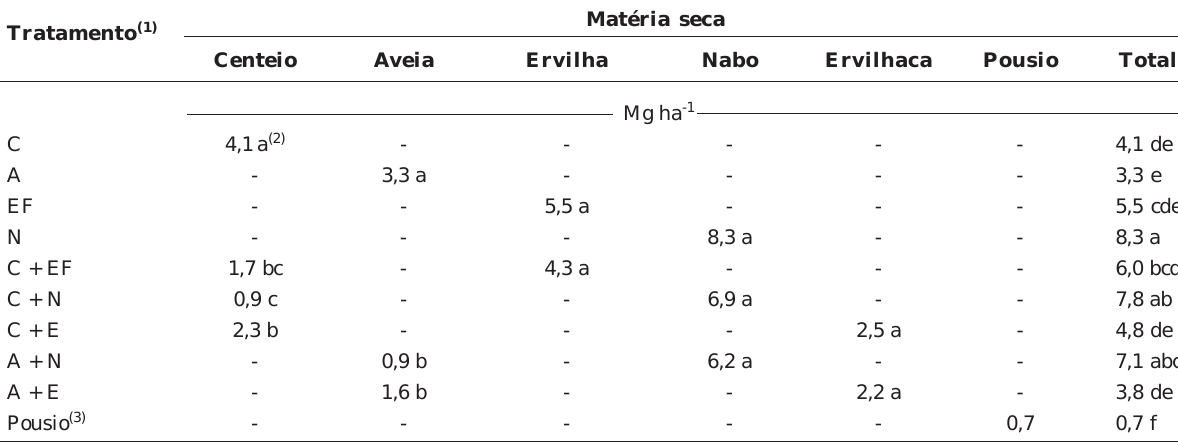
(1) C=centeio; A=aveia-preta; EF=ervilha forrageira; NF=nabo forrageiro; E=ervilhaca comum. (2) Médias seguidas de mesma letra nas colunas não diferem entre si pelo teste de Tukey a 5 %. (3) A MS do tratamento em pousio refere-se à vegetação espontânea da área. Média de quatro